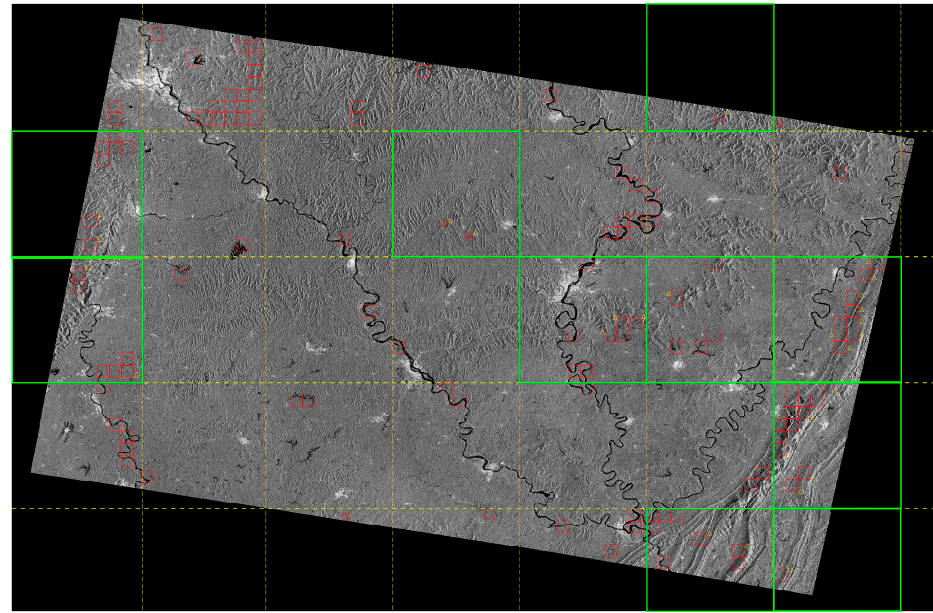
Figure 5. Sentinel-1 VV polarized data of the study area (15 July 2018) with the target bimodal regions (in red boxes) using CV X and R X , where the false alarms are notated by a yellow triangle beside them.